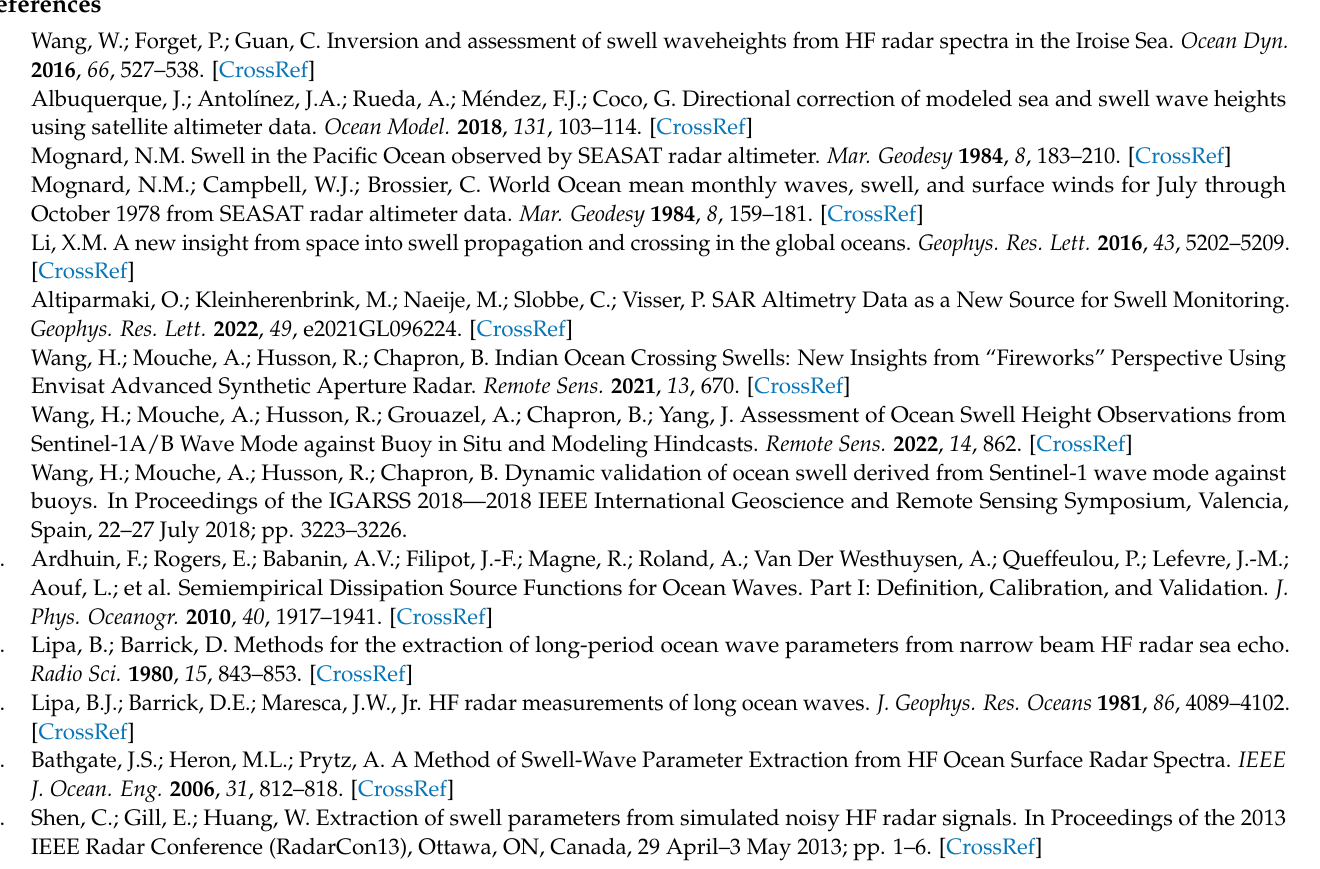
estimates and ERA5 swell height data; Figure S2: Scatter density plots of CY04 swell height estimates and ERA5 swell height data; Figure S3: Scatter density plots of CY05 swell height estimates and ERA5 swell height data; Figure S4: Scatter density plots of CY06 swell height estimates and ERA5 swell height data; Figure S5: Scatter density plots of CY07 swell height estimates and ERA5 swell height data; Figure S6: Scatter density plots of CY08 swell height estimates and ERA5 swell height